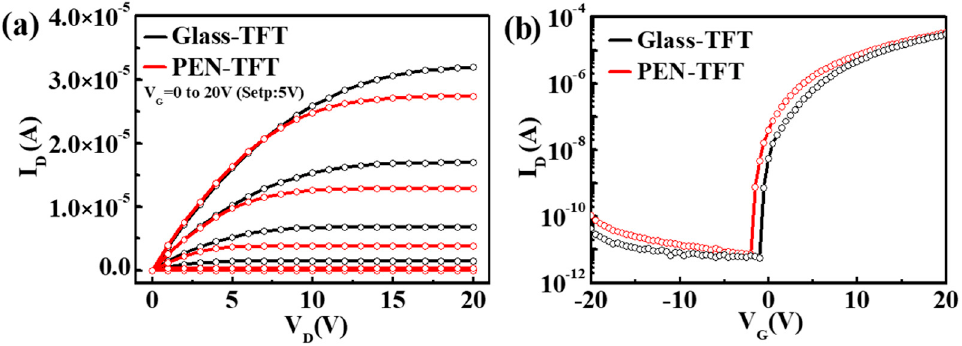
Figure 2. Comparison of ( a ) output and ( b ) transfer characteristics between Glass-TFT and PEN- TFT.